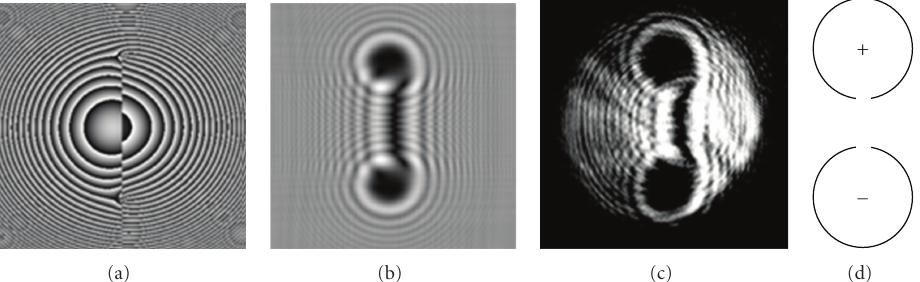
Figure 6: Fresnel lens with fractional vortices of opposite charge (3.5) embedded at o ff -axis locations. (a) Phase distribution displayed on SLM. (b) Simulated intensity distribution near the focal plane. (c) Experimentally observed intensity distribution near the focal plane. (d) Distribution of topological charge in the intensity